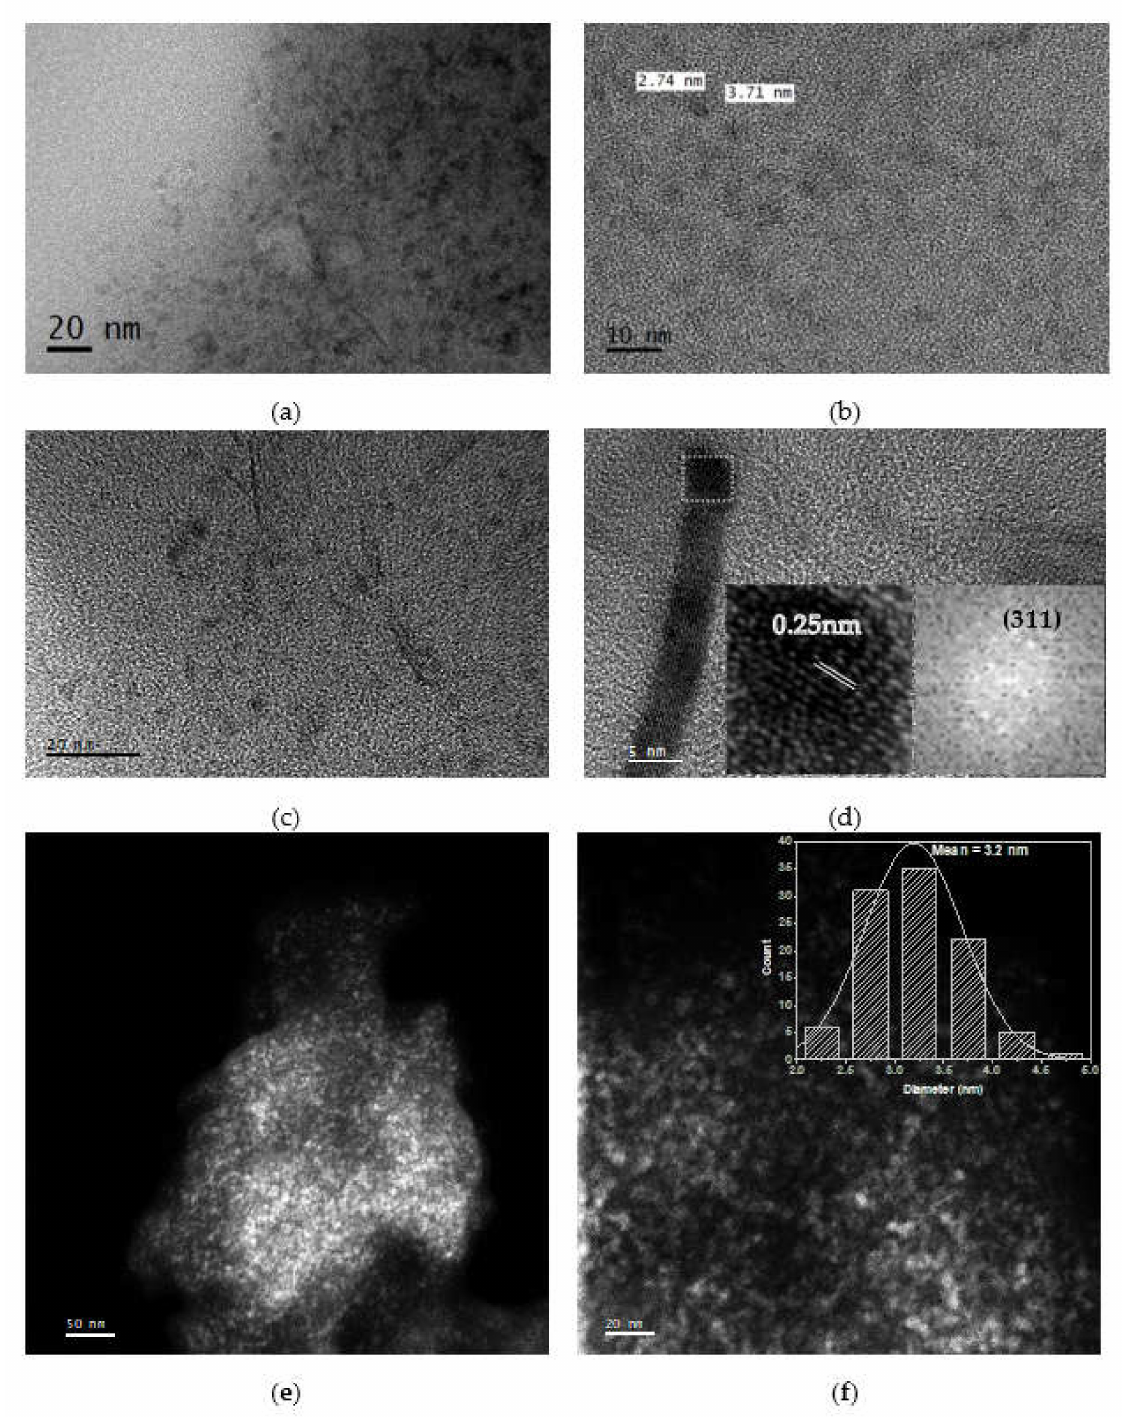
Figure 1. ( a – d ) TEM images and ( e – f ) STEM images of synthesized MIONPs. The SEM image is seen in Figure 2a with its point EDS analysis applied in the box marked. The EDS spectrum recorded for the nanoparticles is shown in Figure 2b, where a strong signal for elemental iron is observed at 6.2 keV and another small signal at 7.1 keV. The presence of an oxygen peak at 0.6 keV indicates that iron oxides were formed. The mass relationship corresponds to Fe 3 O 4 . Similar results were obtained using Ridge gourd peel extract [17] to synthesize magnetite